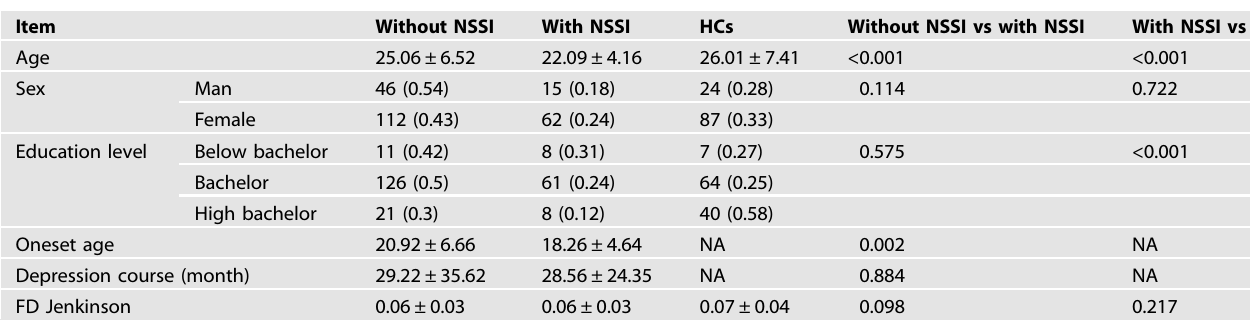
Table 1. Demographic